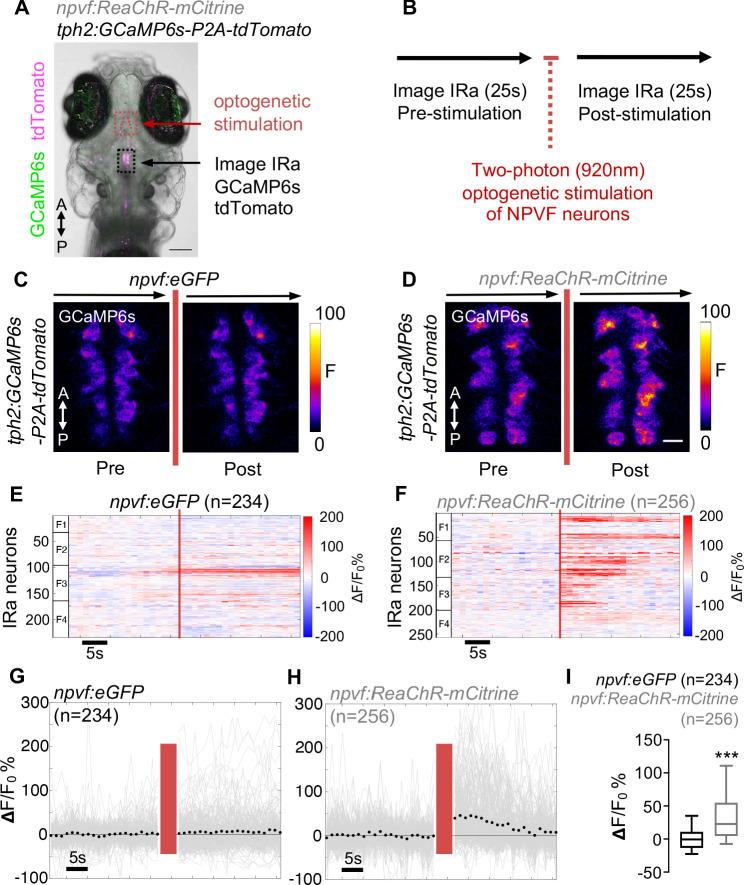
Optogenetic stimulation of NPVF neurons activates serotonergic IRa neurons.6-dpf Tg(npvf:ReaChR-mCitrine); Tg(tph2:GCaMP6s-P2A-tdTomato) and Tg(npvf:eGFP); Tg(tph2:GCaMP6s-P2A-tdTomato) control animals were analyzed for GCaMP6s/tdTomato fluorescence levels in IRa neurons before and after optogenetic stimulation of NPVF neurons. (A) Example of a 6-dpf Tg(npvf:ReaChR-mCitrine); Tg(tph2:GCaMP6s-P2A-tdTomato) animal showing GCaMP6s and tdTomato fluorescence in IRa neurons with overlayed NPVF neurons (red circles, different z-plane) indicating region of optogenetic stimulation (red box). Black box indicates region where IRa neurons were imaged and analyzed in subsequent panels. Green and magenta signals in the eyes are due to autofluorescence. (B) Normalized GCaMP6s fluorescence in the IRa was first recorded for 25 s (20 frames). NPVF neurons were then optogentically stimulated for 3.7 s (red line), and normalized GCaMP6s fluorescence in the IRa was then immediately imaged again for 25 s. (C,D) Average GCaMP6s fluorescence in IRa neurons for 10 imaging frames before (Pre) and after (Post) optogenetic stimulation of NPVF neurons in Tg(npvf:eGFP); Tg(tph2:GCaMP6s-P2A-tdTomato) (C) and Tg(npvf:ReaChR-mCitrine); Tg(tph2:GCaMP6s-P2A-tdTomato) (D) animals. (E–H) Normalized GCaMP6s fluorescence of individual IRa neurons shown as heat maps (E,F), in which each horizontal line represents an IRa neuron, and as line graphs (G,H) showing individual (gray lines) and mean (dotted line) IRa neuron responses before and after optogenetic stimulation (red lines) in Tg(npvf:eGFP); Tg(tph2:GCaMP6s-P2A-tdTomato) control (E,G) and Tg(npvf:ReaChR-mCitrine); Tg(tph2:GCaMP6s-P2A-tdTomato) (F,H) animals. F1-F4 in (E,F) indicate neurons from four different fish. (I) Box plot of normalized GCaMP6s ΔF/F0 values from the average of the first 10 imaging frames post-stimulation of each neuron for Tg(tph2:GCaMP6s-P2A-tdTomato) animals that also contain either a Tg(npvf:eGFP) (black) or Tg(npvf:ReaChR-mCitrine) (gray) transgene. n = number of neurons quantified from four animals of each genotype. ***p<0.001, Mann-Whitney test. Scale: 100 μm (A), 10 μm (D).